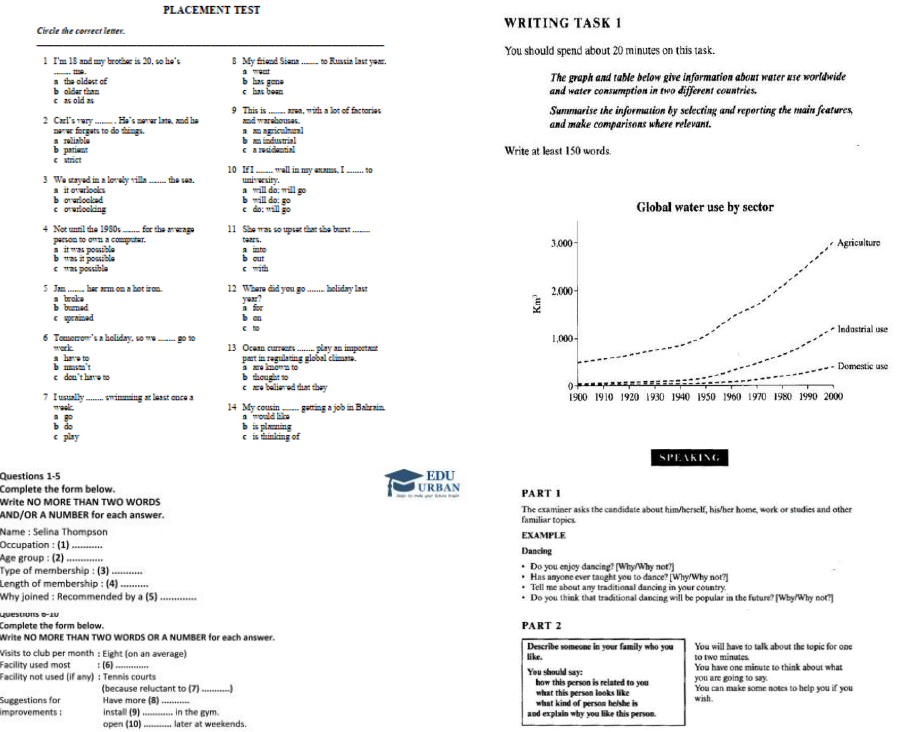
Figure 1: Pre-test